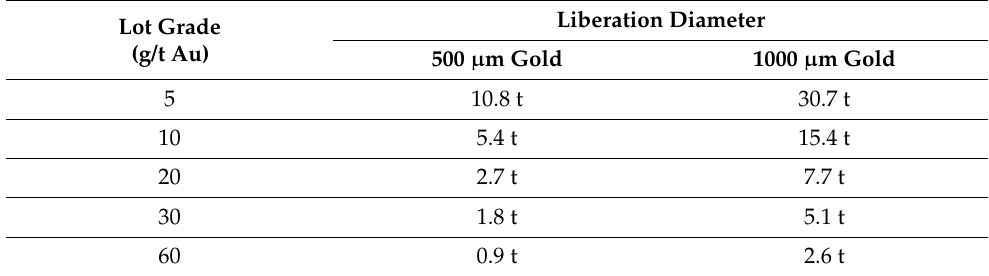
Table 10. The FSE-optimised sample mass for a fine- and coarse-gold ore, based on achieving a precision of ± 15% at the 90% confidence limits. The residue top size is taken as 10 cm. Liberation Lot Grade (g/t Au)